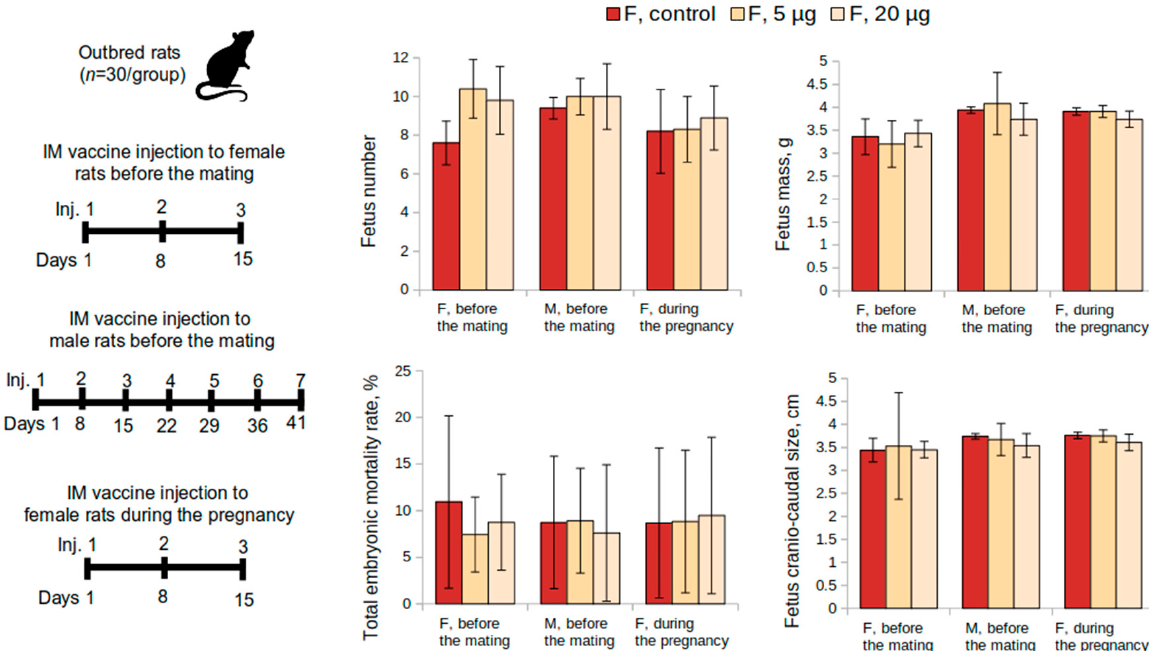
Figure 2. Examination of the reproductive system according to the following parameters: fetus number, fetus mass, total embryo mortality rate, fetus craniocaudal size from female rats intramuscularly immunized with the “Betuvax-CoV-2” vaccine 15 days before mating (F, before the mating), before mating with males previously immunized during a 48-day period (M, before the mating), and during the first 19 days of the pregnancy (F, during the pregnancy). F—females, M—males; IM—intramuscular administration; p > 0.05.